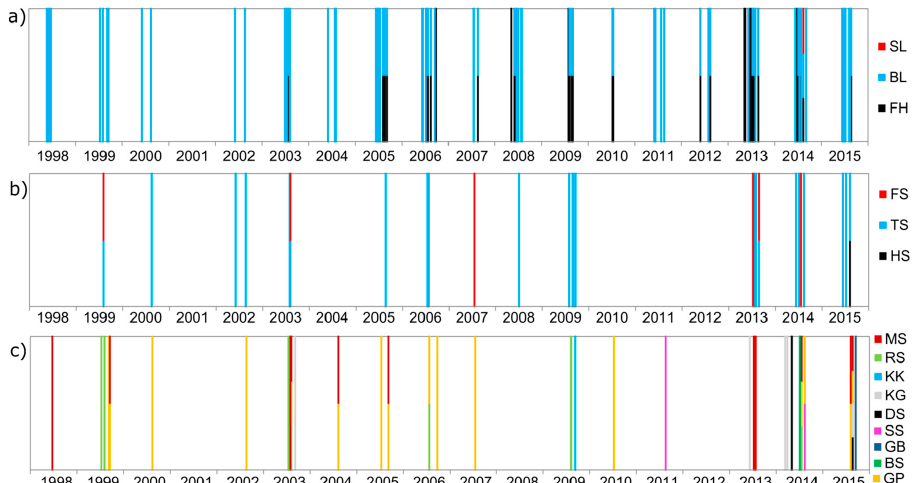
Figure 14. Frequency and duration of Landsat-derived calcite precipitation events at the study areas (1998–2015, cf. Appendix A). Images with calcite precipitation are illustrated as bars. ( a ) The Feldberg Lake District with FH, BL, and SL; ( b ) the Klocksin Lake Chain with Flacher See (FS), Tiefer See (TS), and Hofsee (HS); and ( c ) the Rheinsberg Lake Region with Menowsee (MS), Roofensee (RS), Kleiner Krukowsee (KK), Kleiner Glietzensee (KG), Dagowsee (DS), Stechlinsee (SS), Großer Boberowsee (GB), Breutzensee (BS) and Großer Paelitzersee (GP). When more than one lake shows calcite precipitation at the same date, the bars of the lakes are stacked.